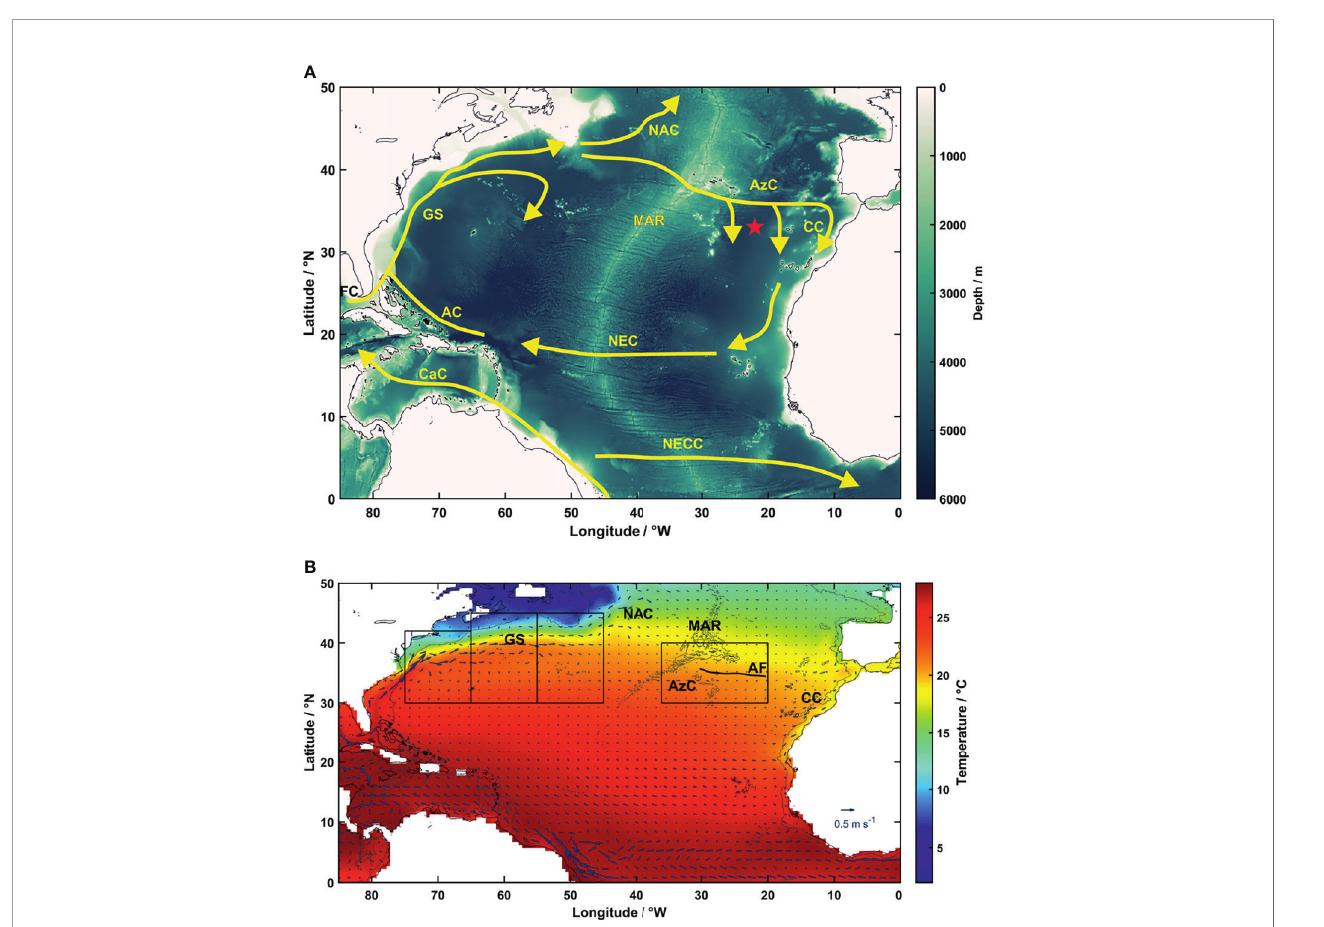
FIGURE 1 | North Atlantic circulation at the surface. (A) Schematic representation of the North Atlantic Subtropical Gyre currents at the surface: Caribbean Current (CaC), Florida Current (FC), Antilles Current (AC), Gulf Stream (GS), North Atlantic Current (NAC), Azores Current (AzC), Canary Current (CC), North Atlantic Equatorial Current (NEC), and North Atlantic Equatorial Counter Current (NECC). Mid-Atlantic Ridge (MAR) and the Kiel 276 mooring (red star) are also identi fi ed (adapted from Tomczak and Godfrey, 1994 and Daniault et al., 2016). (B) Mean temperature and mean velocity at 5 m depth in the North Atlantic basin from the SODA-POP v2.2.4 (Carton and Giese, 2008; Giese and Ray, 2011) averaged between 1871 and 2010. Black boxes show our study domains in the Gulf Stream (between 75°W and 45°W, divided into three 10° sub-zones) and in the Azores Current (between 36°W and 20°W). A thin grey line depicts the 2000 m-isobath. The time-averaged annual position of the Azores Front (AF) position is represented by a thick black line between 30°W and 20°W for the period